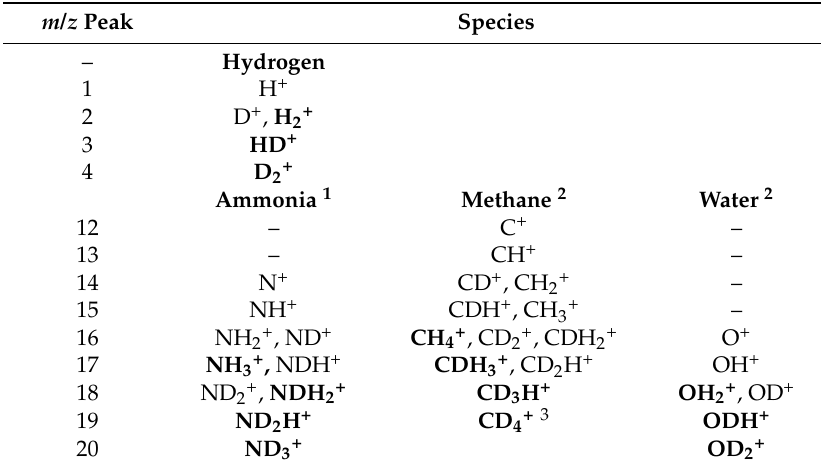
Table 1. Contribution of molecular (in bold) and fragmented ions to the different peaks ( m / z ) in the mass spectrometry (MS) for Reactions (1) and (2). Hydrogen is common for the two